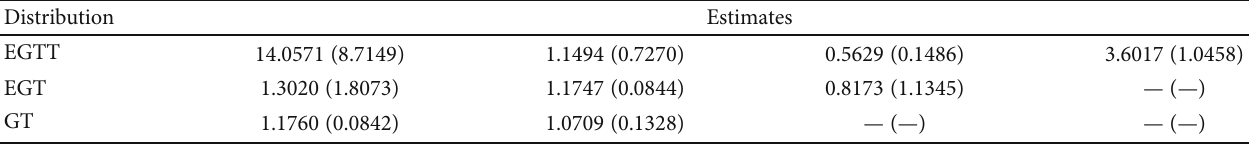
Table 3: Parameter estimate and standard error (parenthesis).